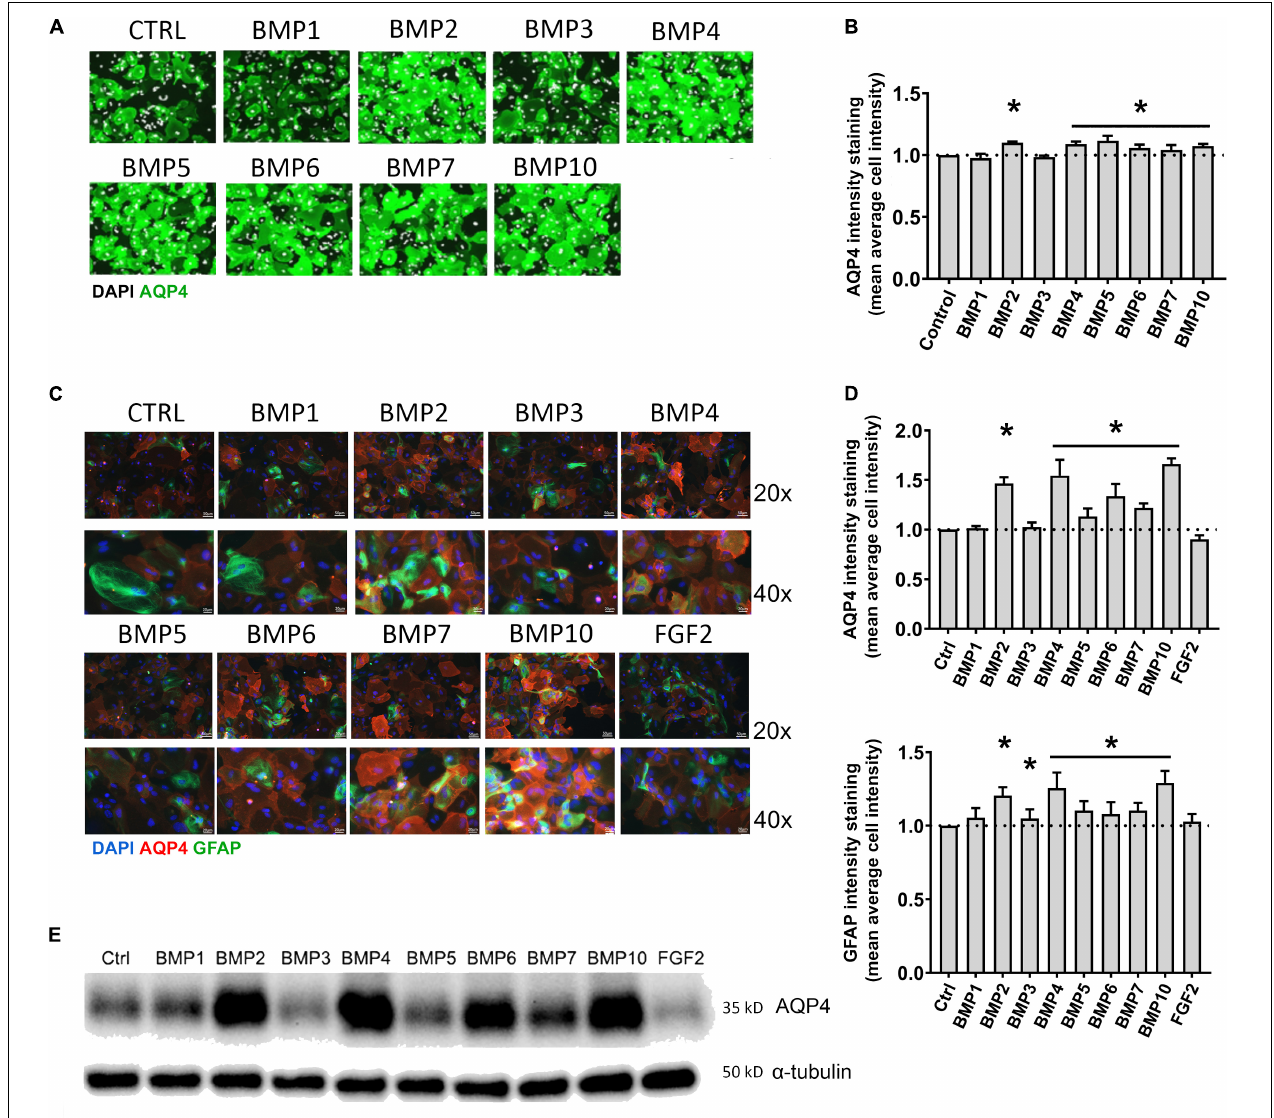
FIGURE 1 | BMPs upregulate AQP4 in mESC astrocytes and primary mouse astrocytes after 6 days treatment. (A) Plate Runner assay on mESC derived astrocytes treated with BMPs and immunostained with an antibody to AQP4 demonstrate stronger immunofluorescence intensities (green) in calls treated with BMPs –2, –4, –5, –6, –7, and –10. AQP4 staining shown in green, nuclear staining with DAPI is shown in white pseudocolor. (B) Assessment of fluorescence intensity reveals a significant increase in AQP4 staining in cells treated with BMPs –2, –4, 5, 6, 7, and 10 when comparing mean average cell intensities. The AQP4 immunofluorescent intensity in cells treated with BMP1 and BMP3 is not different from that of the untreated cells (CTRL). Staining intensity is presented as fold changes of mean average cell intensity normalized to that of untreated cells. *Sig ANOVA LSD post-hoc test, horizontal lines with * indicates significance in several samples; error bars: SEM; P < 0.05; n = 4. (C) Plate Runner assay on matured primary astrocytes treated with BMPs and immunostained with antibodies to AQP4 (red) and GFAP (green) demonstrates stronger immunofluorescence intensities in cells treated with BMPs –2, –4, –5, –6, –7, and –10. AQP4 staining shown in red, nuclear staining with DAPI shown in blue, GFAP staining shown in green with 20 × and 40 × magnification. (D) Assessment of fluorescence intensity in treated primary astrocytes reveals a significant increase in AQP4 and GFAP staining in cells treated with BMPs –2, –4, –5, –6, –7, and –10 when comparing mean average cell intensities. BMP1, BMP3, and FGF2 do not affect AQP4 staining intensities Staining intensity is presented as fold changes of mean average cell intensity normalized to that of untreated cells (CTRL). *Sig ANOVA LSD post-hoc test, horizontal lines with *indicates significance in several samples; error bars: SEM; P < 0.05; n = 4. (E) Representative immunoblot of primary astrocytes treated with BMPs demonstrates that AQP4 expression on the protein level is increased by BMPs –2, –4, –6, –7, and –10, while corresponding α -tubulin expression is not affected. Samples from two separate experiments were run in parallel in the same gel with identical results, n = 2.